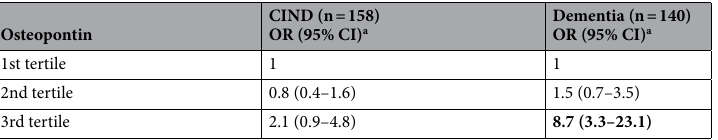
Table 2. Association between osteopontin and cognitive impairment, expressed in odds ratios (OR) and 95% confidence interval (CI). Bold values indicates p < 0.05 using binary logistic regression. CIND, cognitive impairment no dementia; n, number; OR, odds ratio; CI, confidence interval. a Adjusted for age, education, hypertension, diabetes and cardiovascular disease.